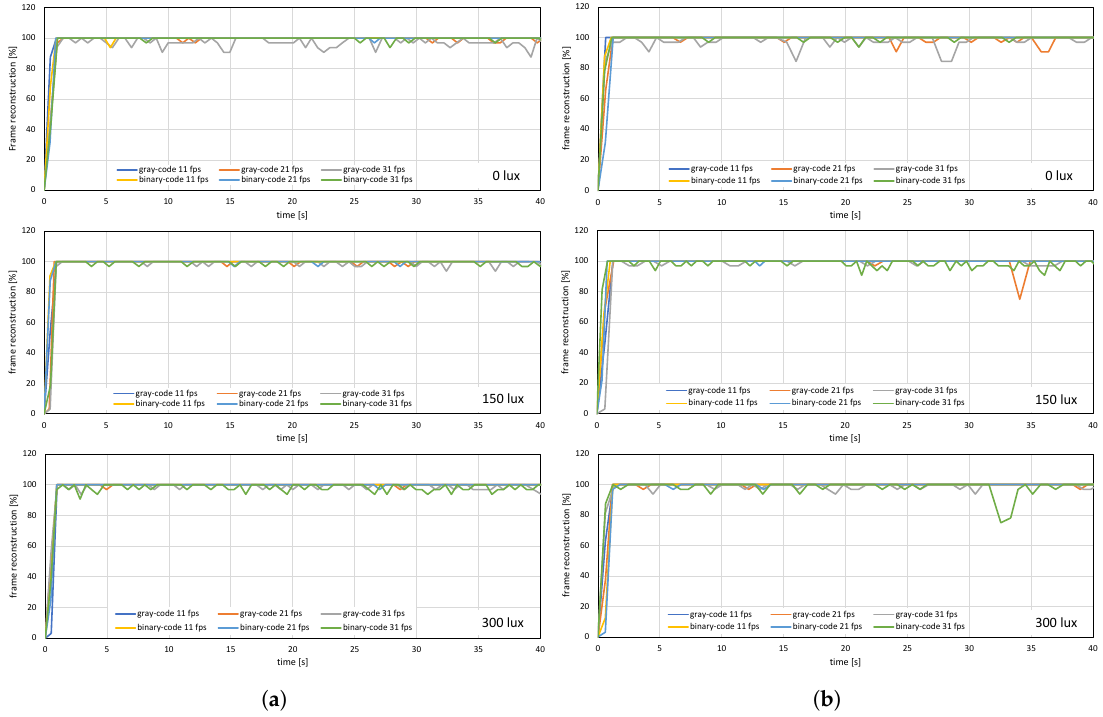
Figure 22. Frame reconstruction ratio when USB camera video is streaming on ( a ) plain background and ( b ) patterned